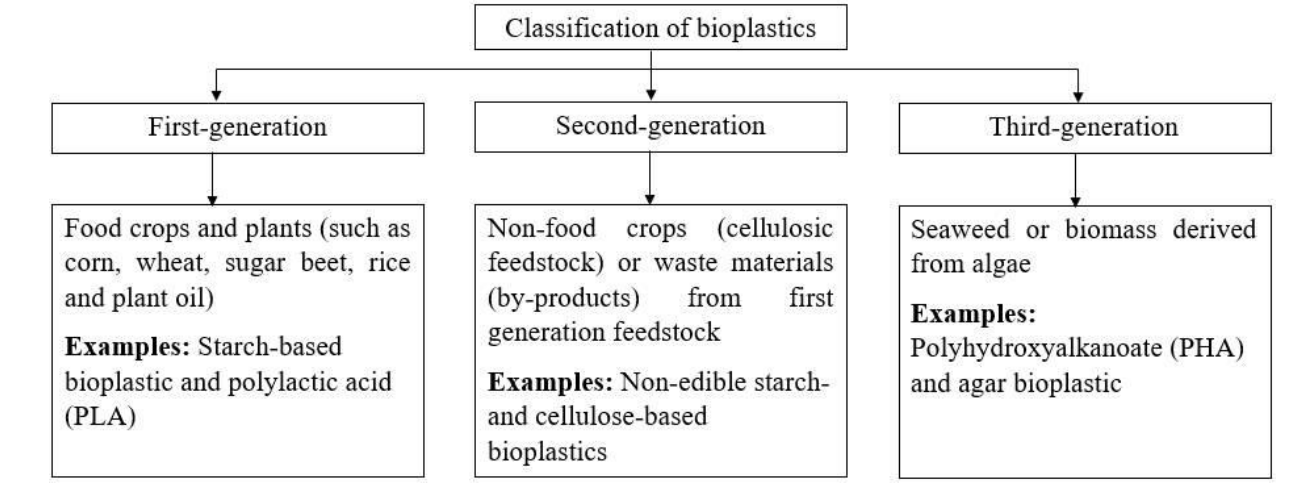
Figure 1. Classifications of bioplastics based on